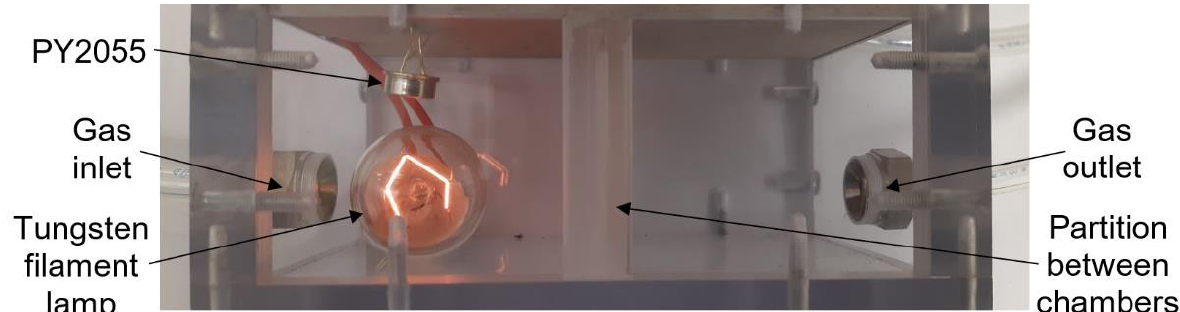
Figure 9. Photograph of infrared sensor PY2055 in test chamber.